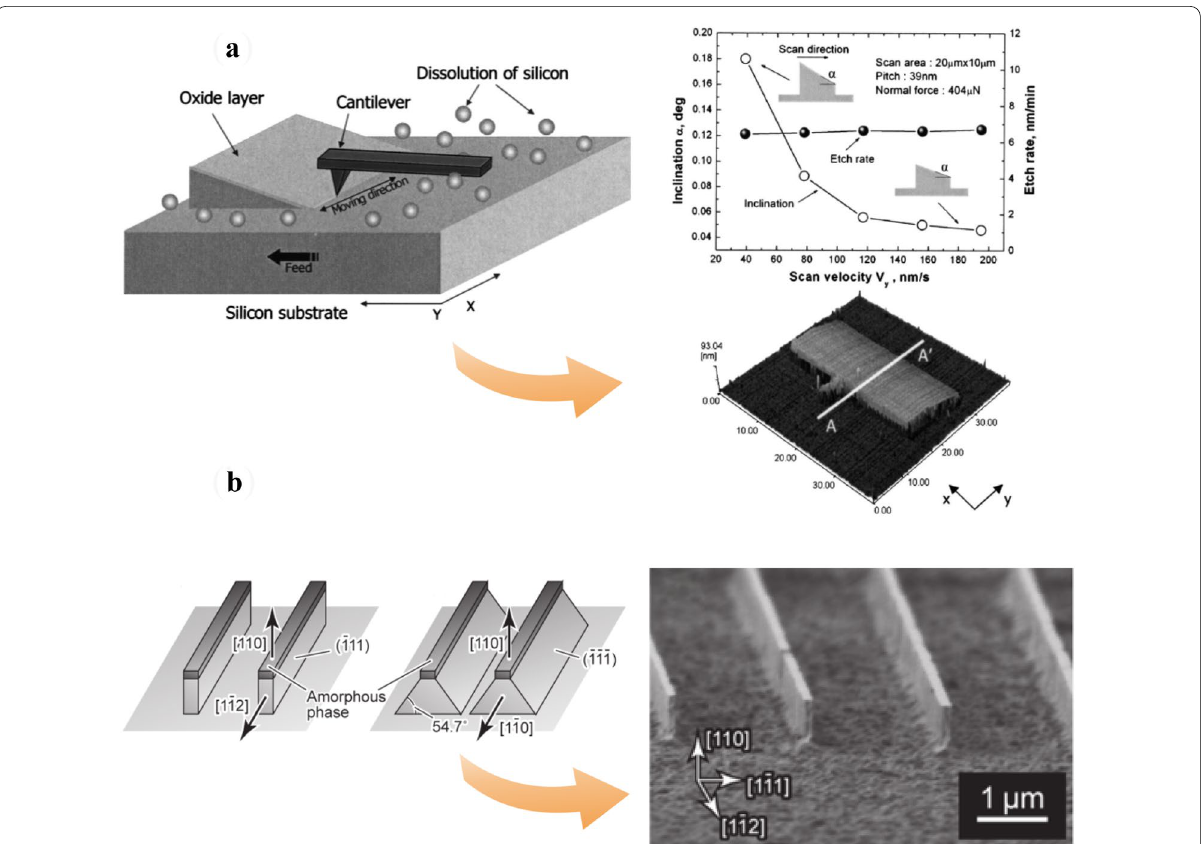
Figure 12 Fabrication of silicon nanostructures through scratching silicon surfaces with a diamond tip followed by subsequent wet etching [61, 62]: ( a ) Schematic diagram showing the sliding process in KOH solution. The right panel displayed AFM topography of fabricated structures, and the correlation of inclination (α) of the protrusive structures and scratching speed in the y direction ( V y ). ( b ) Schematic diagram showing the shape of the structure fabricated by the scratching along <112> and <110> directions. The right panel displayed SEM image of high-aspect-ratio structures fabricated by the scratching along <112> direction and subsequent etching in KOH